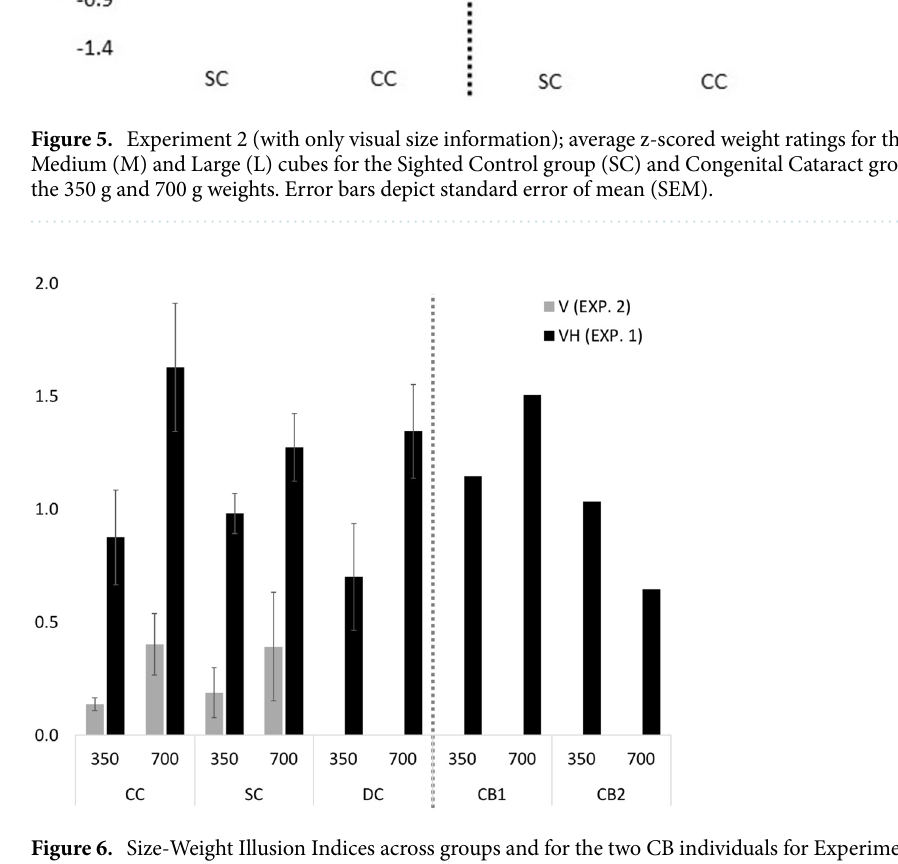
Figure 6. Size-Weight Illusion Indices across groups and for the two CB individuals for Experiment 1 (with visual and haptic size information, black bars, labelled VH) and Experiment 2 (with only visual size information, gray bars, labelled V), for the 350 g and 700 g weights. The y-Axis depicts the difference in z-scores between the large and small cubes of each weight, averaged for each group (CC, DC, and SC). Error bars depict the